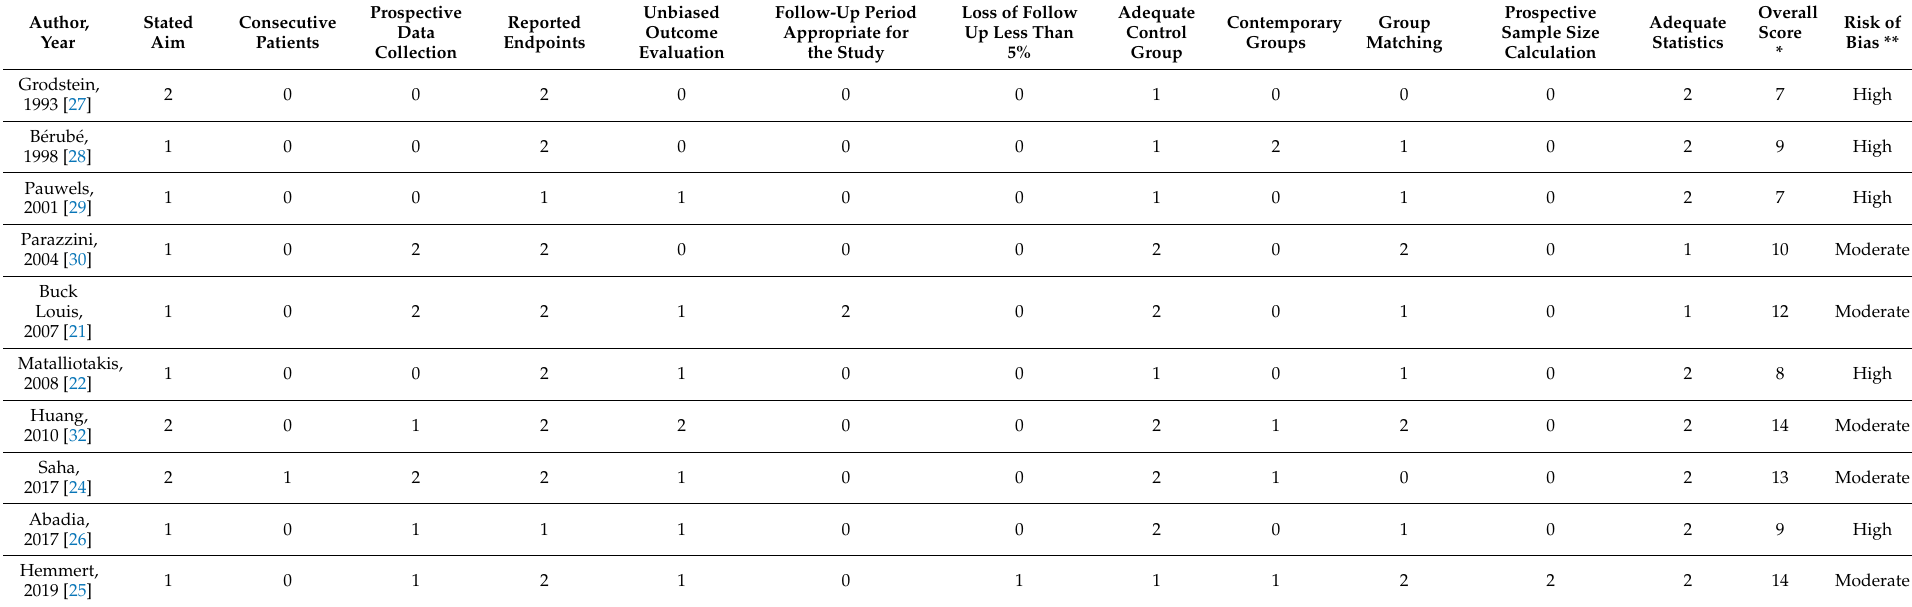
Table 2. Risk of bias assessment of the included studies (MINORS